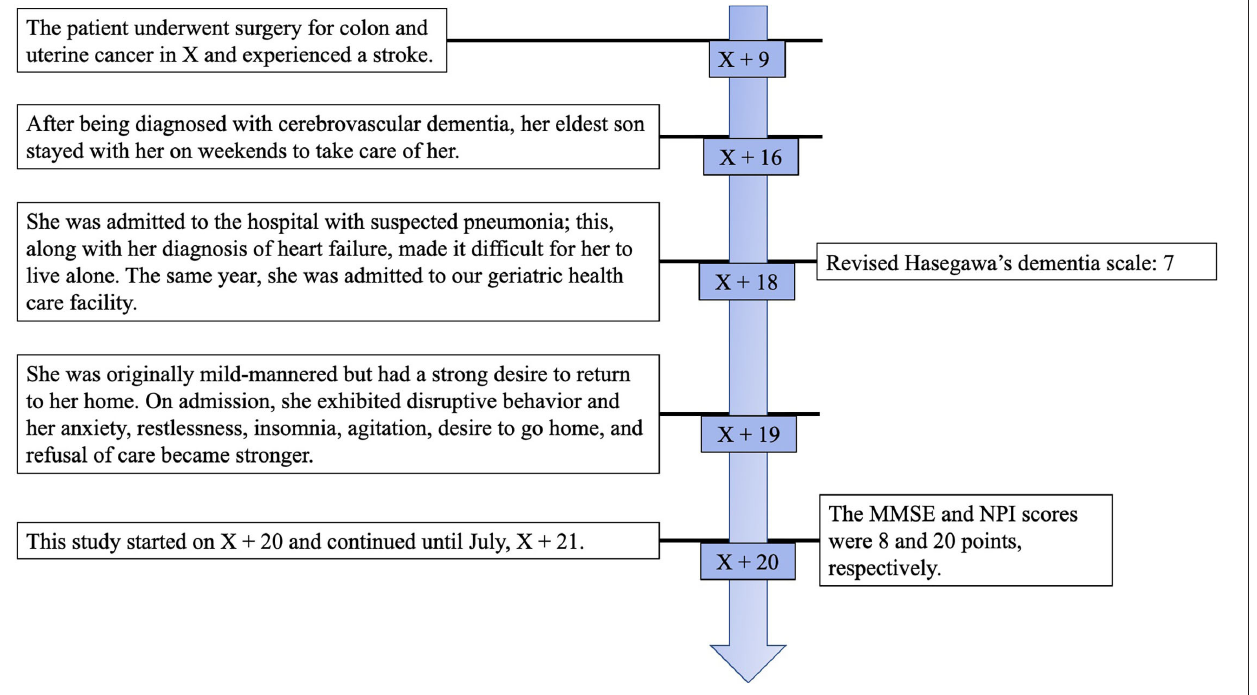
FIGURE 1 | Clinical findings,